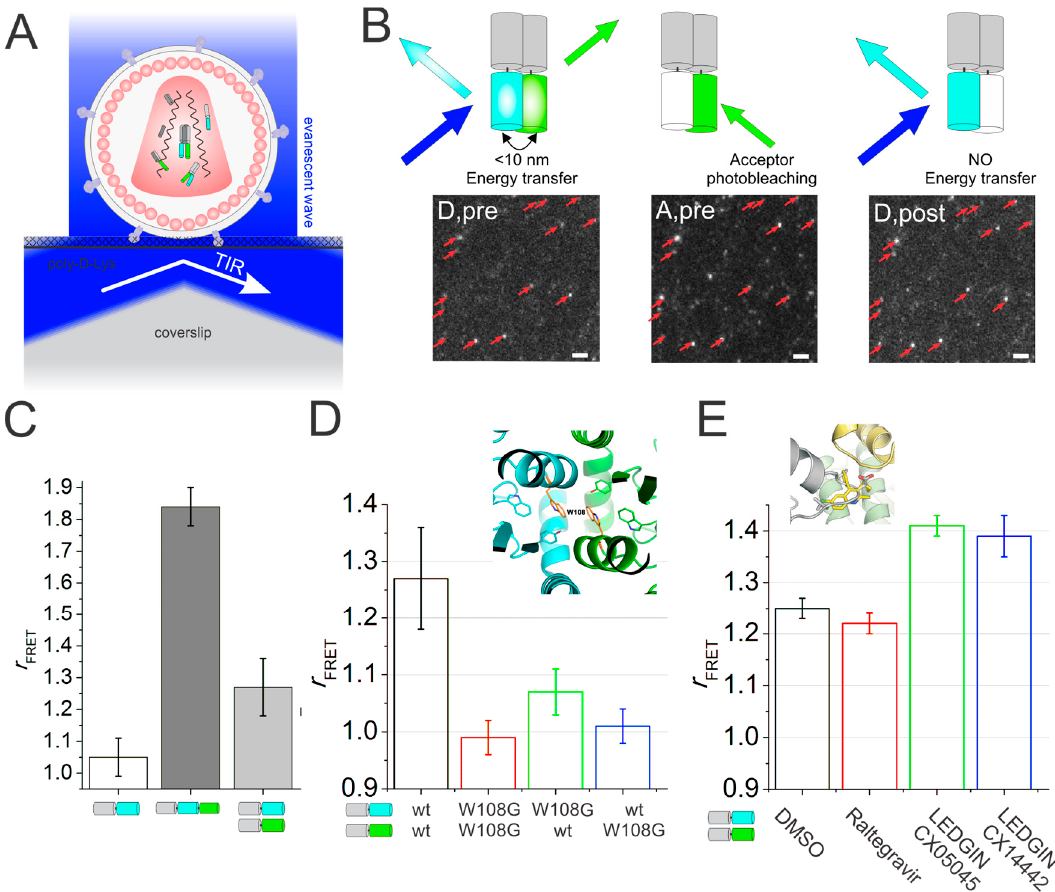
Figure 1. ( A ) Cartoon of total internal reflection fluorescence microscopy (TIRFM) imaging of mature human immunodeficiency virus (HIV-1) viral particles containing fluorescently labeled IN. Single-virus TIRFM enables clear imaging of immobilized single HIV viral particles in a small region (~200 nm) close to the coverslip at high signal-to-noise ratio (SNR). ( B ) The principle of acceptor photobleaching Förster resonance energy transfer (FRET) in HIV-1 viral particles. “Pre” and “post” describes the sample pre- and post-acceptor photobleaching. (left panel) The fluorescence of mTFP1 in viral particles containing donor and acceptor FP (Donor, pre) capable of FRET (<10 nm) is quenched by the proximal acceptor (mVenus). After photobleaching of the acceptor (middle panel), the donor is dequenched (right panel). Scale bar = 1 µ m. Red arrows indicate fluorescent HIV-1 particles. ( C ) Mean FRET ratio of HIV IN-mTFP1+IN-mVenus (light gray), HIV IN-mTFP1 (white) and HIV IN-mTFP1-mVenus (dark grey). ( D ) (top) Crystal structure of the IN catalytic core dimer interface. W108G is indicated as orange sticks colored by atom. (bottom) mean FRET ratio of wild type (HIV IN-mTFP1+IN-mVenus ) and mutant (IN W108G ). ( E ) (top) Co-crystal structure of LEDGINs bound in the LEDGF/p75 binding pocket of HIV-IN (green and yellow). (bottom) Influence of adding compounds during viral production on the mean FRET ratio. ©Borrenberghs et al., 2014. Originally published in ACS NANO. https://pubs.acs.org/doi/pdf/10.1021/nn406615v [18].